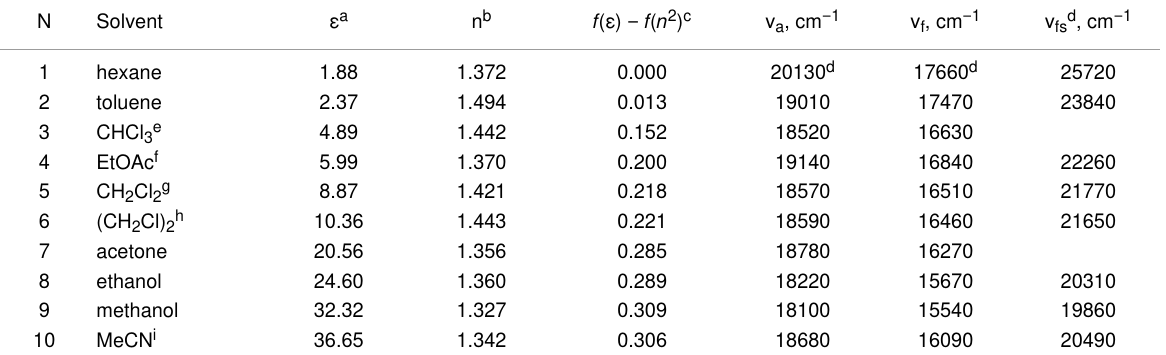
Table 1: Absorption ( ν a ) and fluorescence ( ν f ) maxima of NR, fluorescence maxima ( ν fs ) of the intramolecular charge transfer state of 4-(diisopropyl- amino)benzonitrile (DIABN) in different solvents, solvent dielectric constants ( ε ), refractive indexes ( n ) and Lippert polarity functions at 25 °C . N